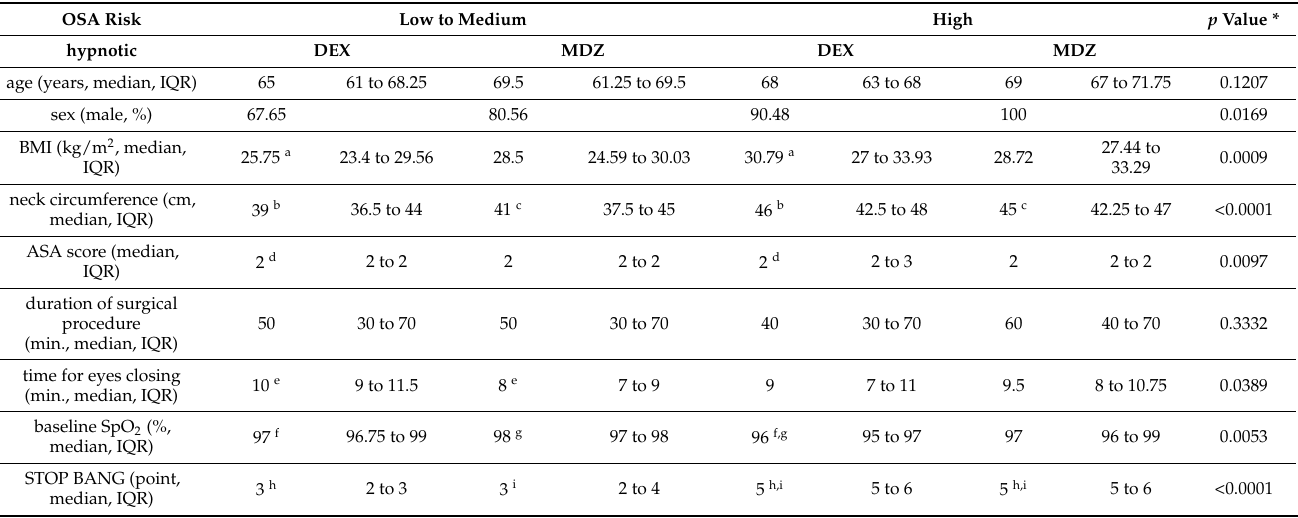
Table 1. Demographic and clinical data.